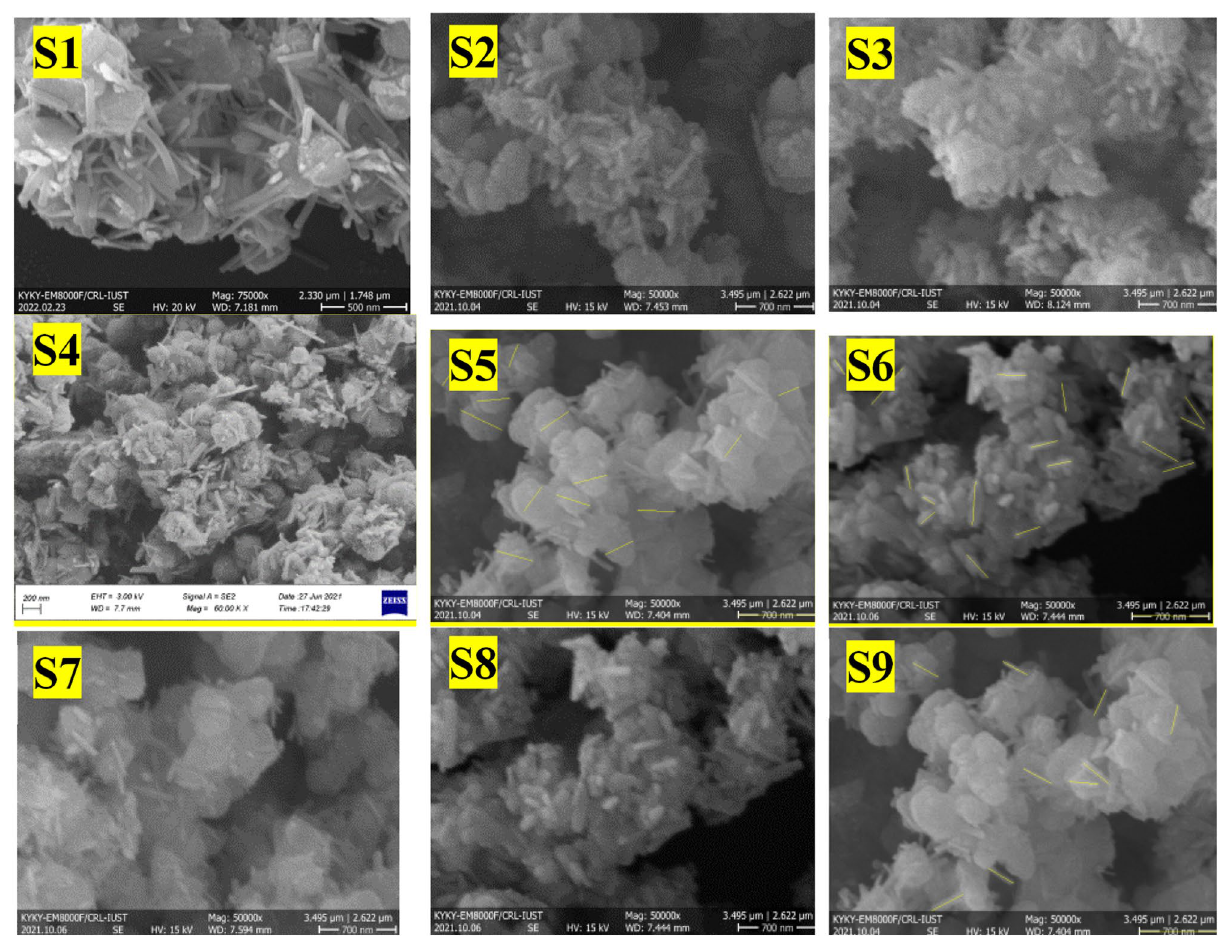
Figure 6. FESEM images of nanourchin-like samples S1–S9.